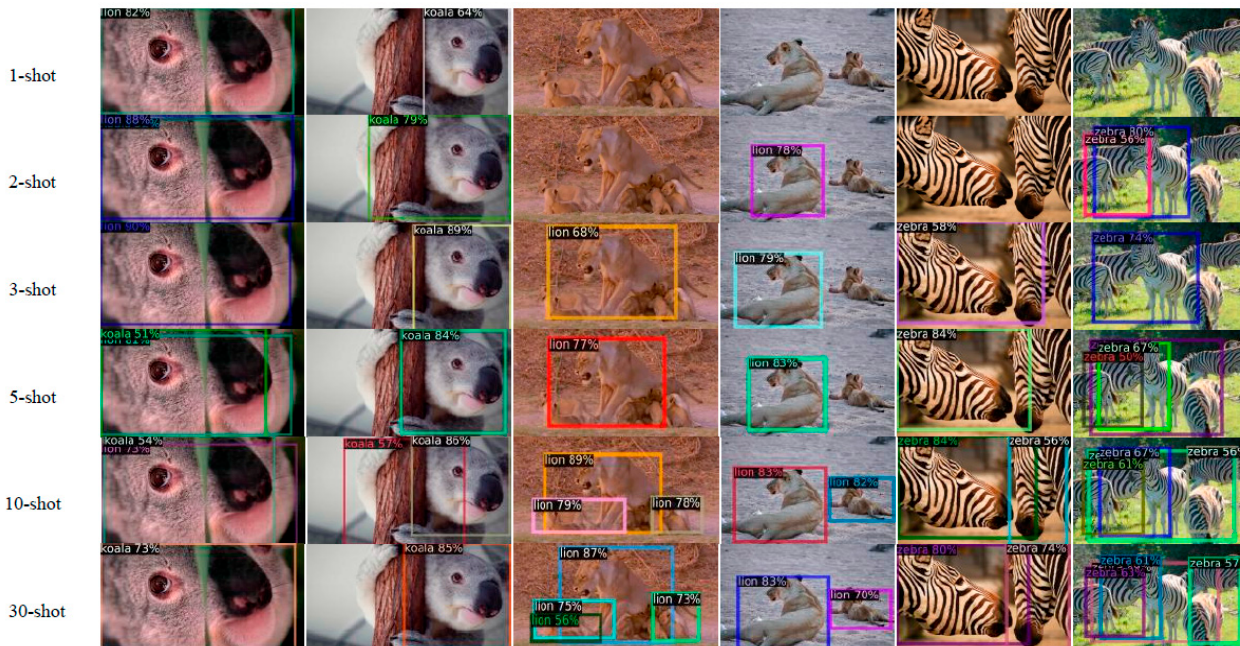
Figure 8. Results for the fine-tuning model of novel classes. In general, the 10- and 30-shot models perform best on both box regression and classification. The 1- and 2-shot models can only detect a few novel classes, because the training samples are too few to train a good model.